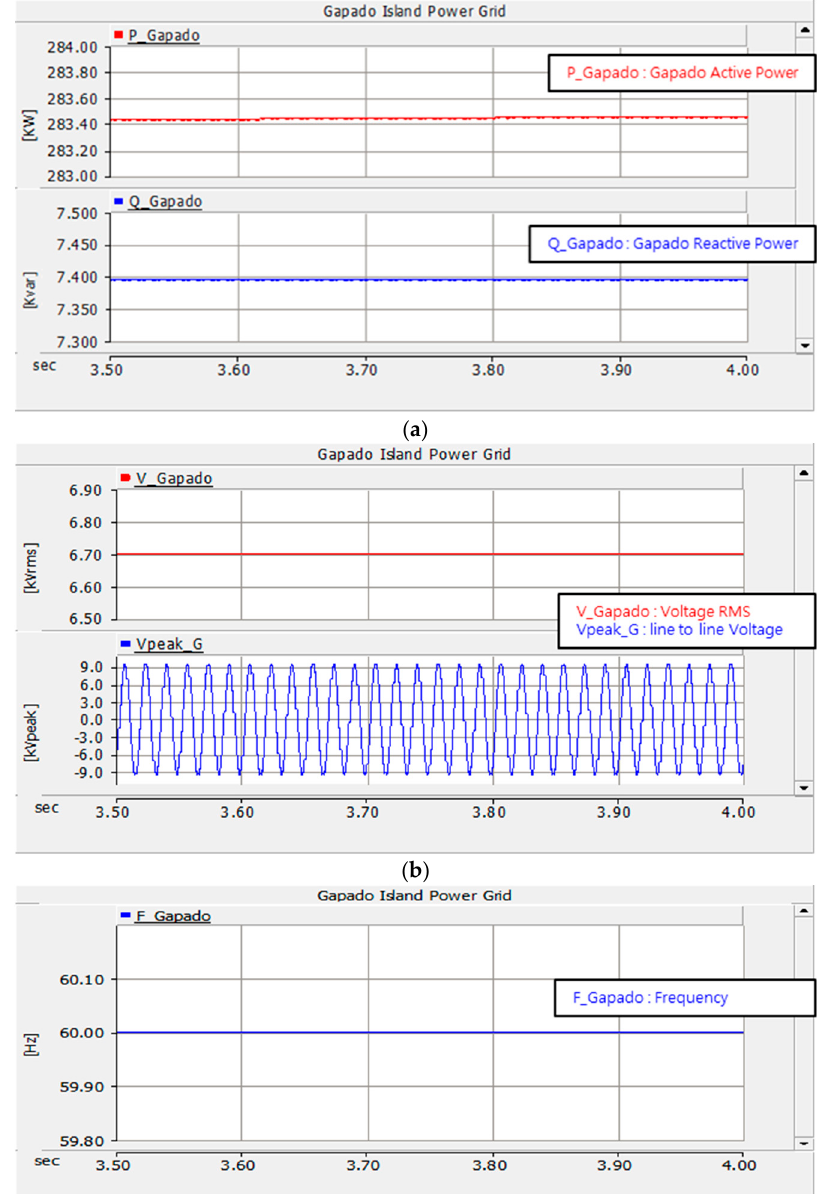
Figure 11. ( a ) Power; ( b ) voltage; ( c ) frequency; waveform in steady state.